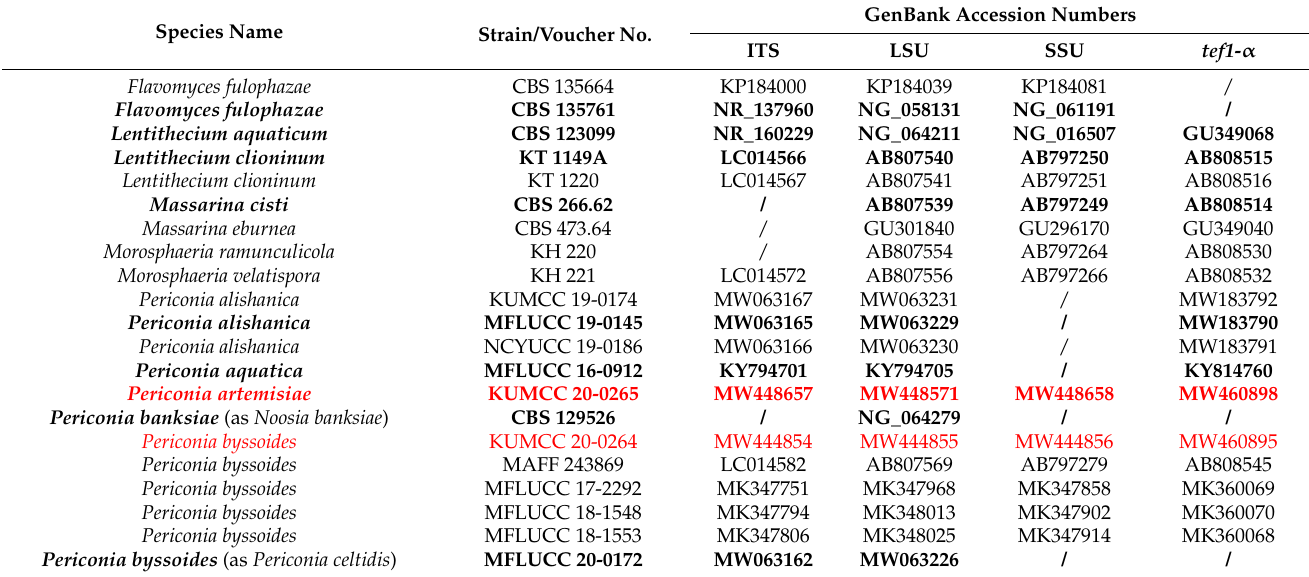
Table 1. Species names, strain numbers and corresponding GenBank accession numbers of taxa used in the present phylogenetic